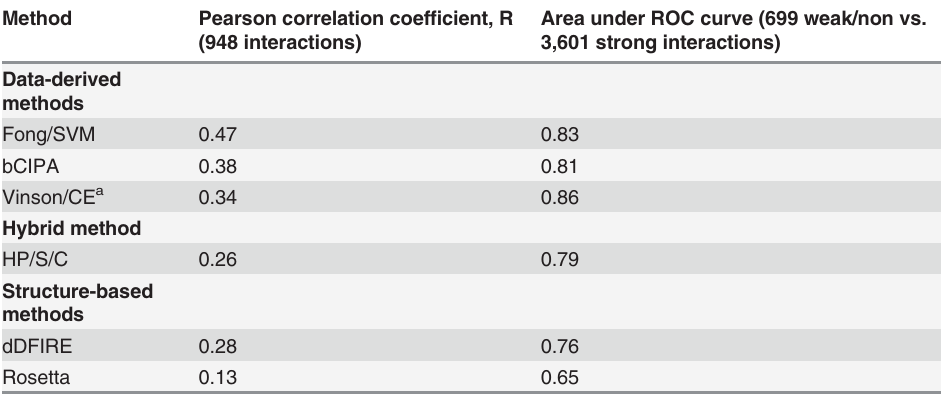
Experimentally determined K d values were compared to predicted scores using two tests: the Pearson correlation coef fi cient (R) and the area under the curve (AUC). The Pearson correlation coef fi cient